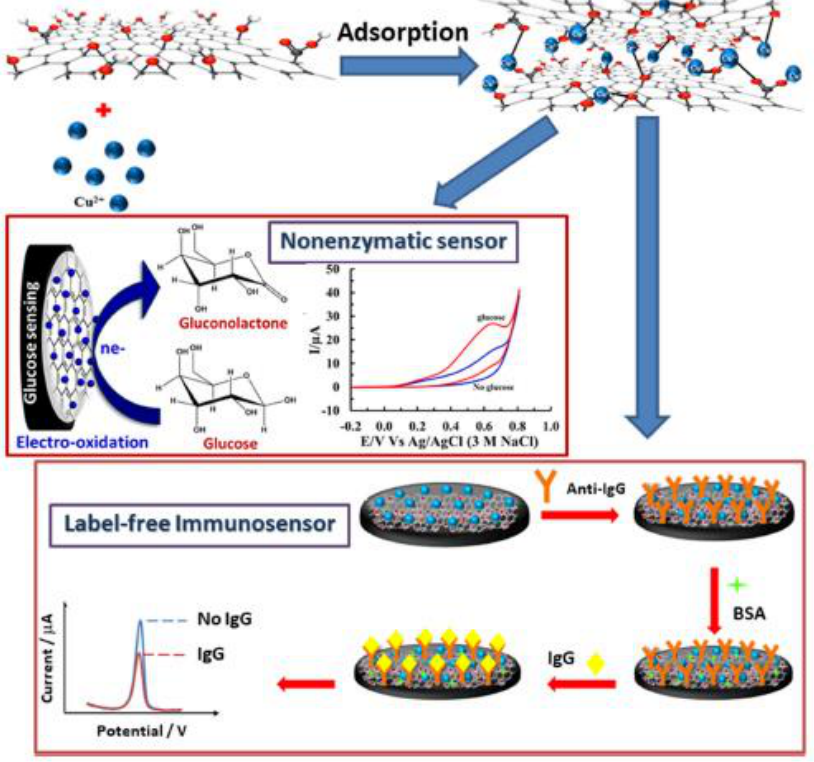
Figure 3. Fabrications of IgG immunosensor and non-enzymatic glucose sensor based on a versatile Cu(II)/GO−modified SPCE. Reprinted with permission from Frontiers from Ref. [44]. Cu(II)/GO − modified SPCE. Reprinted with permission from Frontiers from Ref.